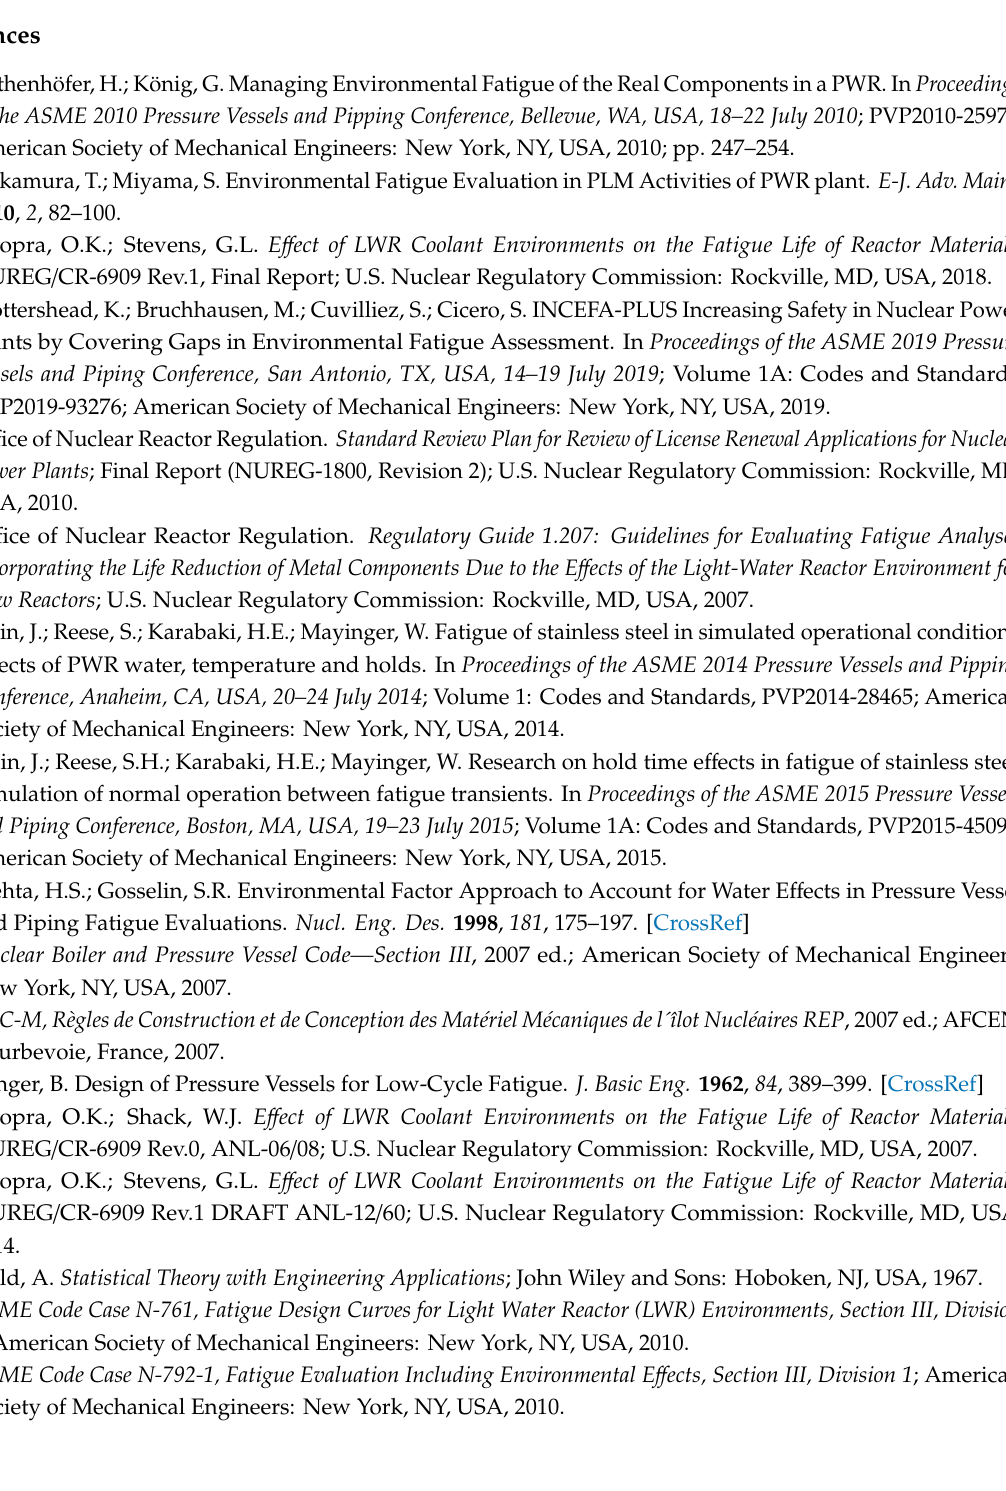
Table A5. Calculations performed to derive CUF and CUF en in the second sequence of real transients. ∆ S ∆ S + secondary stress range in the pair; K p : total stress range in the pair; n : primary penalty factor; S alt : alternative stress; N: number of cycles; N a : maximum number of allowable cycles. Cycle